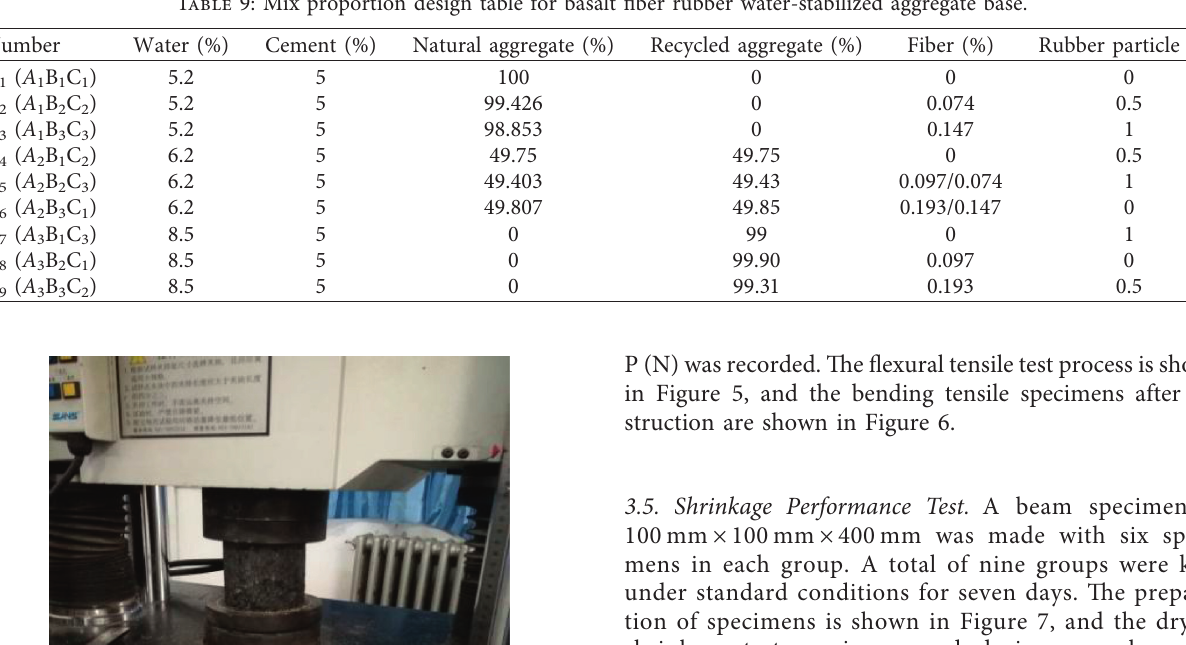
Table 9: Mix proportion design table for basalt fiber rubber water-stabilized aggregate base.